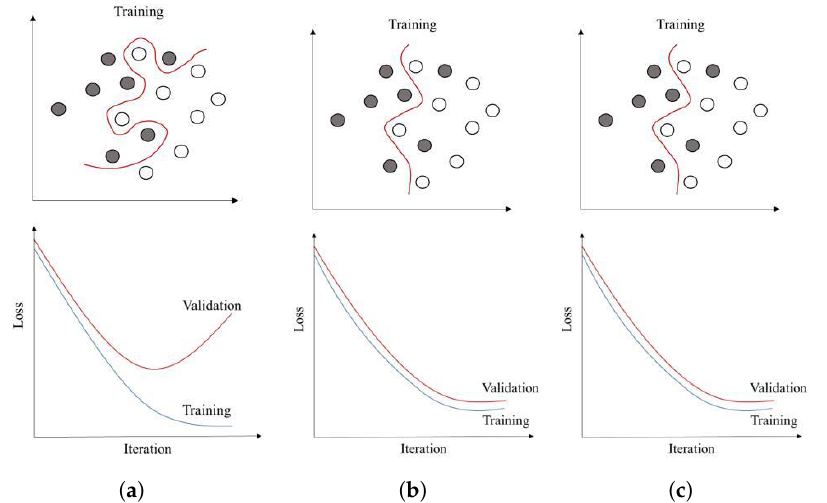
Figure 12. Model complexity and regularization. ( a ) Overfitting: small lambda value. ( b ) Well-fitted: lambda value is tuned. ( c ) Underfitting: large lambda